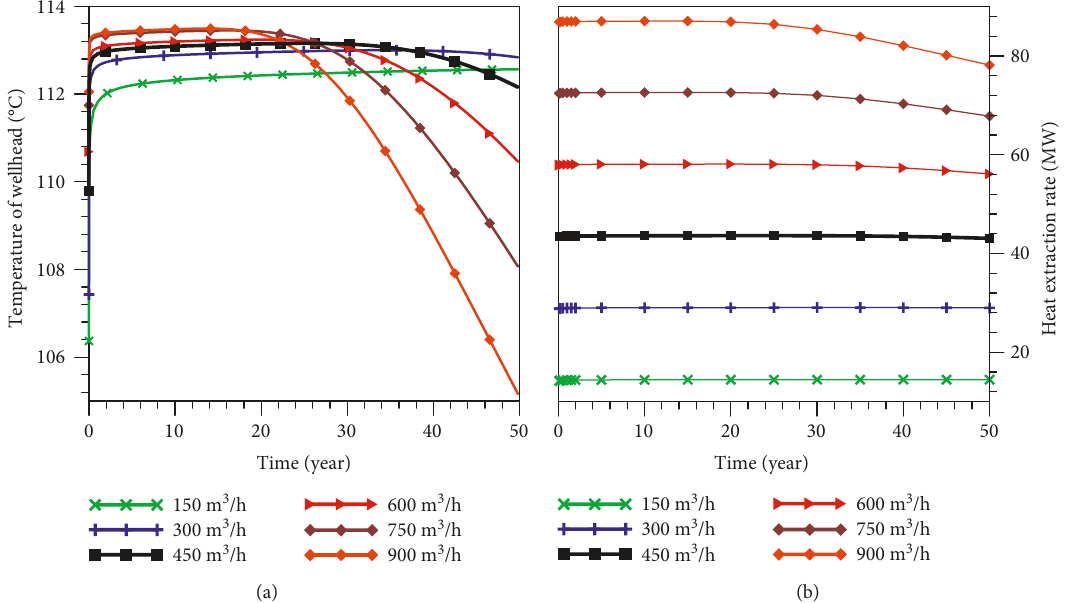
Figure 8: Temperature of outlet water (a) and heat extraction rate (b) variation for di ff erent constant production rates.